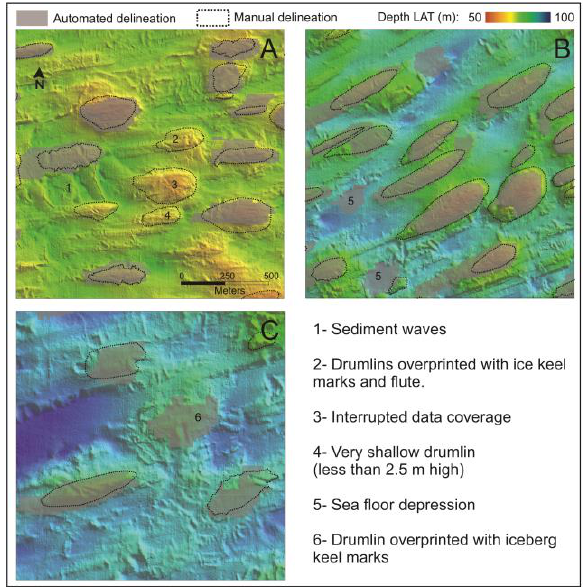
Figure 10. Visual comparison between drumlins extracted in two different method in the submarine environment zoomed in to 3 areas where there is a mismatch between the two